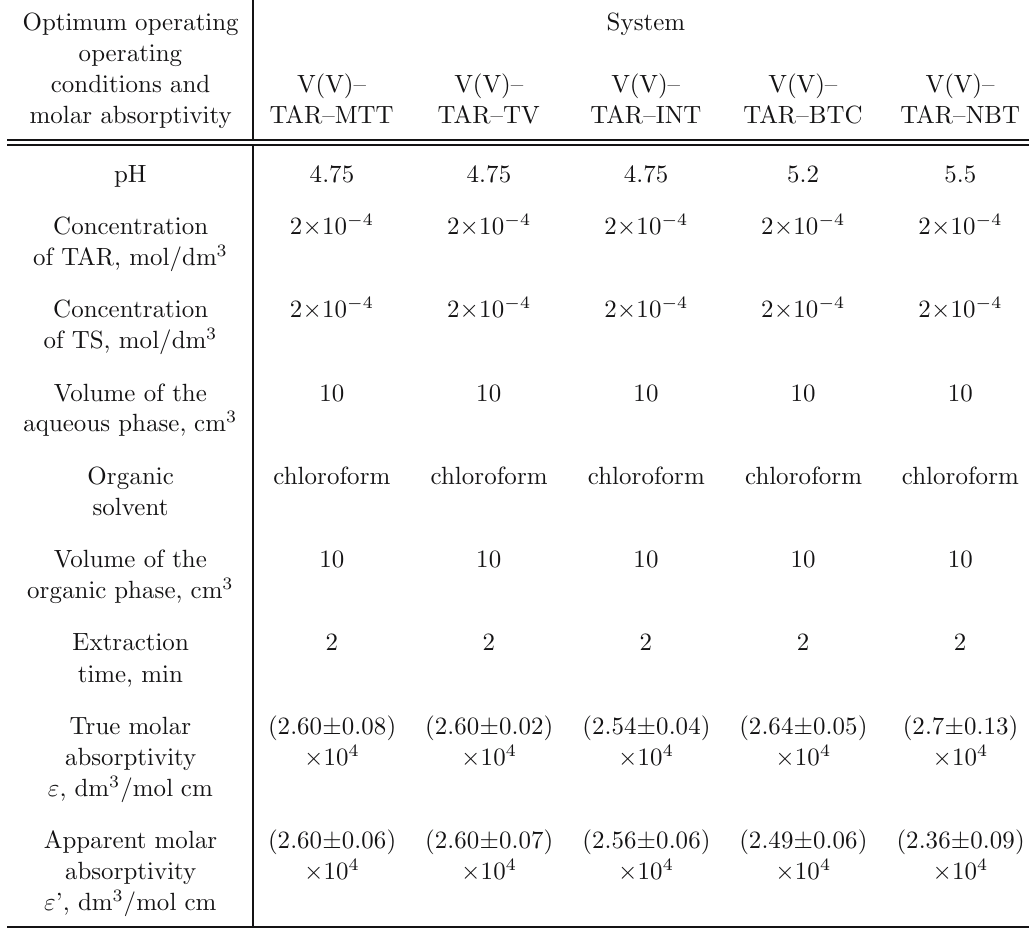
Table 1 Optimum operation conditions and molar absorptivity of the